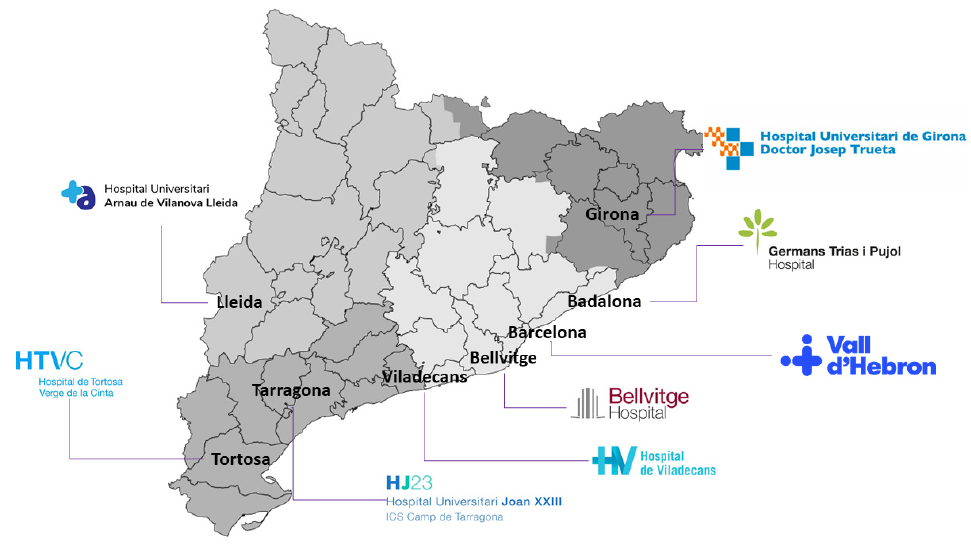
Figure 1. Map of Catalonia and the 8 ICS hospitals.